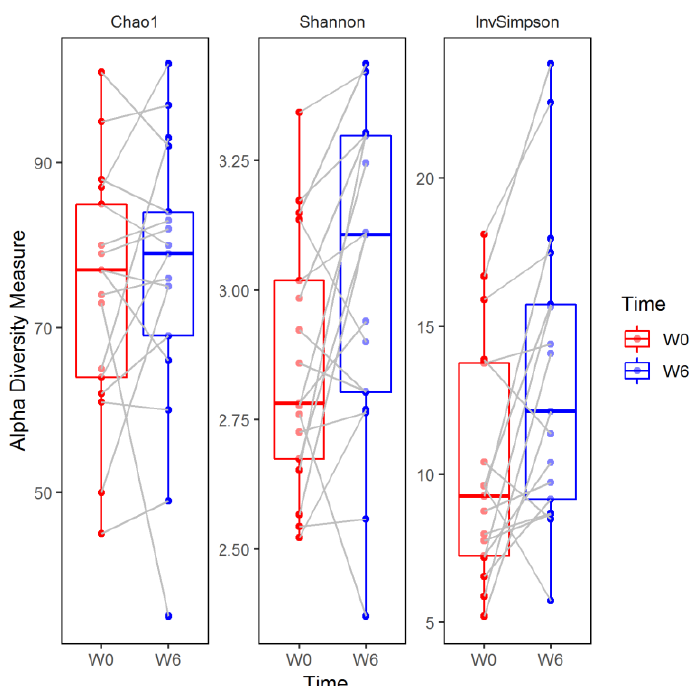
Figure 5. Alpha diversity measures in patients at baseline (W0) and after six weeks of hospitalization (W6). The boxplots represent the diversity measures (center line—median, lower, and upper hinges correspond to the first (Q1) and third (Q3) quartiles; whiskers—the upper whisker is located at the smaller of the maximum alpha diversity measures and Q3 + 1.5 × IQR (Q3 − Q1), the lower whisker is located at the larger of the minimum alpha diversity measures and Q1 − 1.5 × IQR). Paired samples are connected by grey lines. W0 and W6 represent time points. J. Clin. Med. 2019 , 8 , x FOR PEER REVIEW